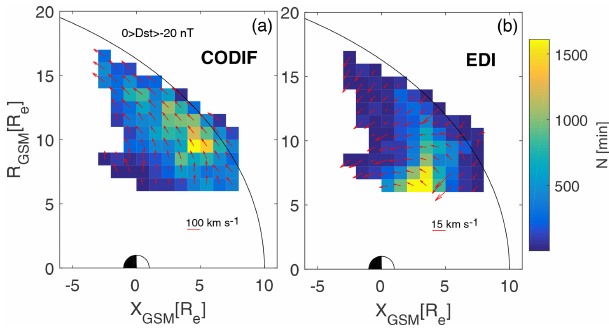
Figure A2. Distribution of average parallel and convection veloci- ties in the cusps and plasma mantle regions for moderate geomag- netic conditions. Labels are the same as in Fig. A1.